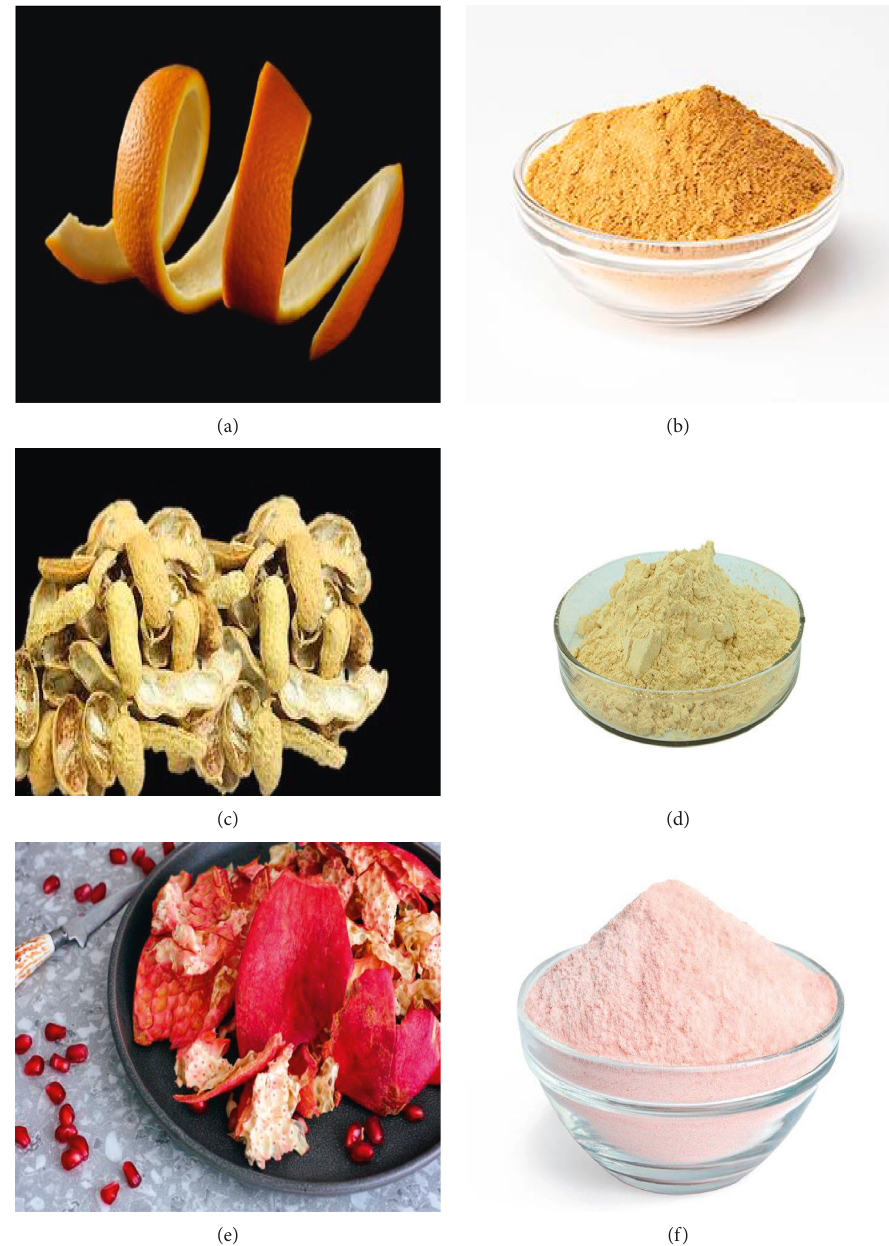
Figure 1: Selective biosorbents: (a) orange peels, (b) grounded powder of orange peels, (c) peanut peels, (d) grounded powder of peanut peels, (e) pomegranate peels, and (f) grounded powder of pomegranate